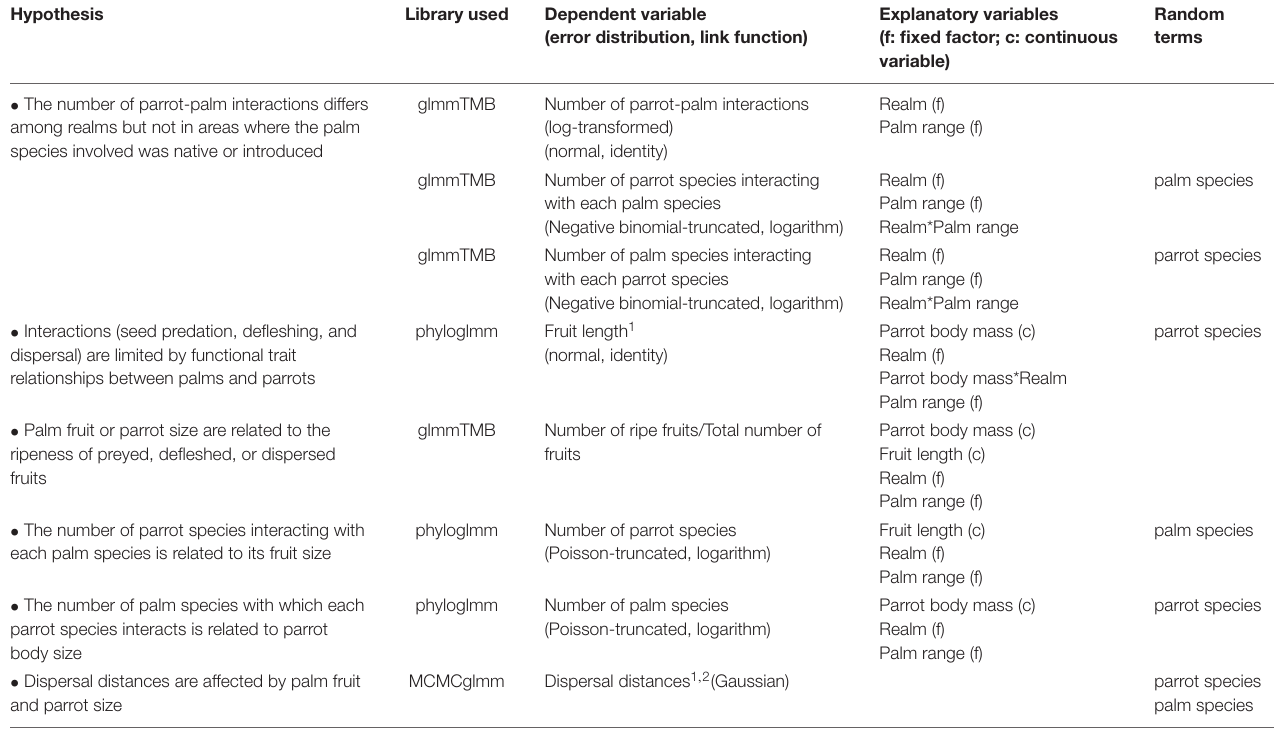
TABLE 1 | Summary of the hypotheses and details about the models used in each case.